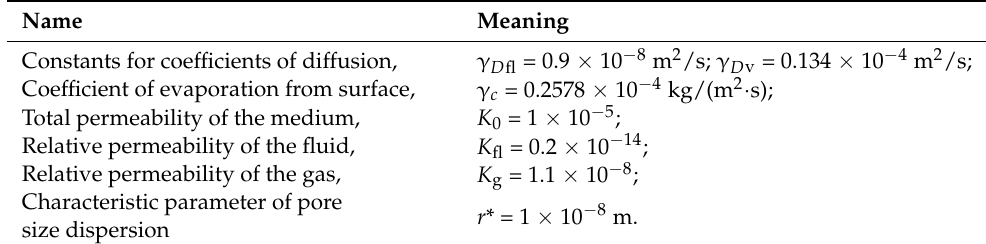
Table 1. Values of refined